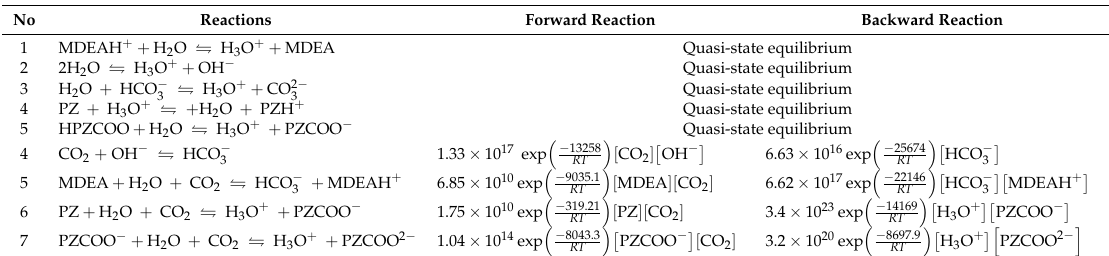
Table 1. Reactions involved in CO 2 absorption by methyl diethanolamine (MDEA)/piperazine (PZ)